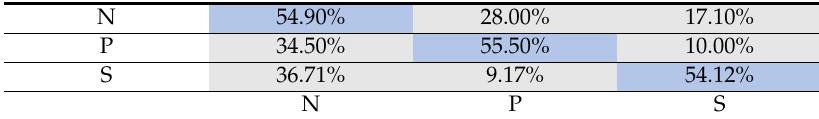
Table 8. Confusion matrix of CBAMNet.